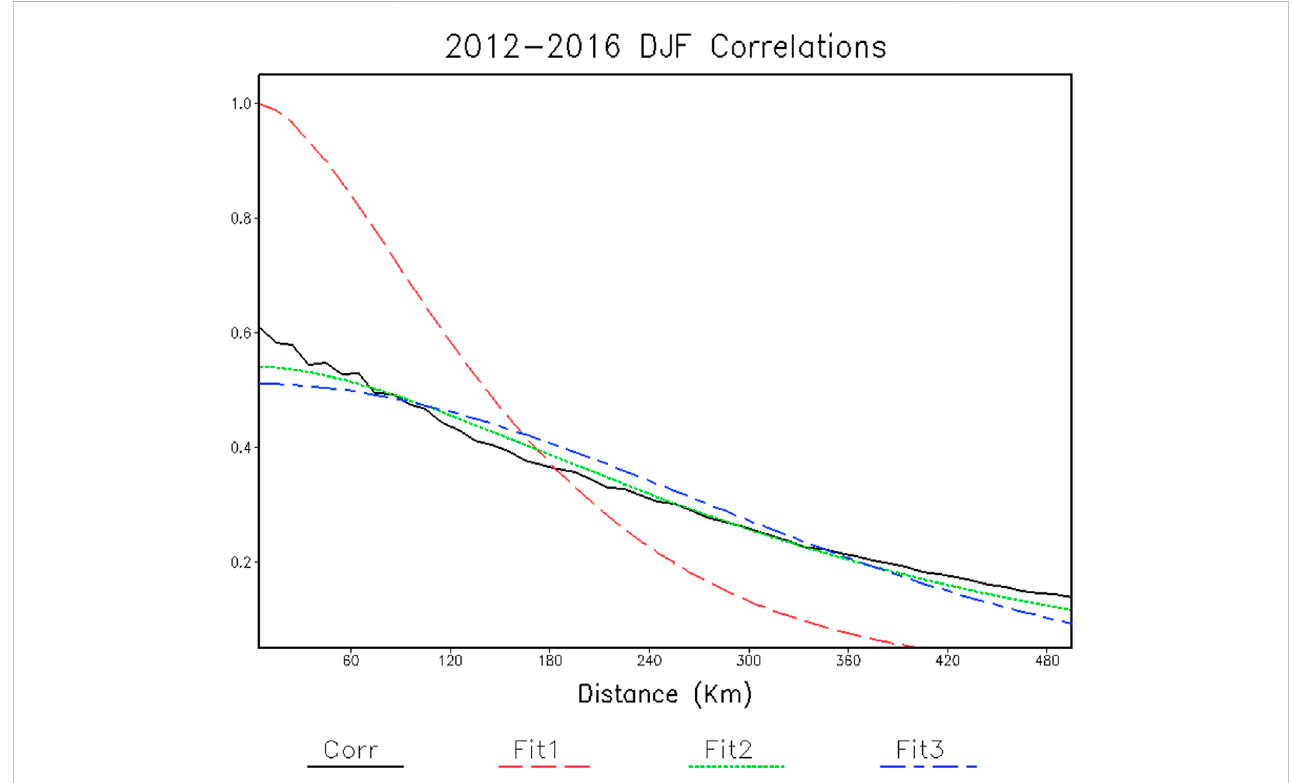
FIGURE 4 Dailysnowdepthincrementcorrelationsasafunctionofhorizontalseparationdistance.Theobservedcorrelations,Corr,andtheindicatedmodel fi tsare shown.